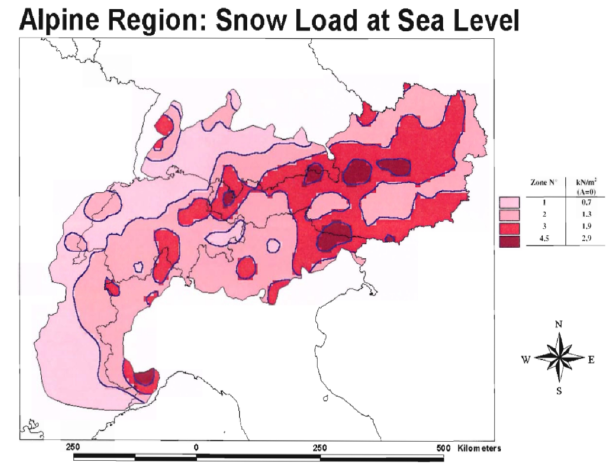
Figure 1. Alpine region snow loads at sea level as provided by the Eurocode EN 1991-1-3 (CEN, 2015). Together with the respective elevation–snow load relationship (see text), the characteristic snow load on the ground ( s k ) can be calculated for every location below 1500m